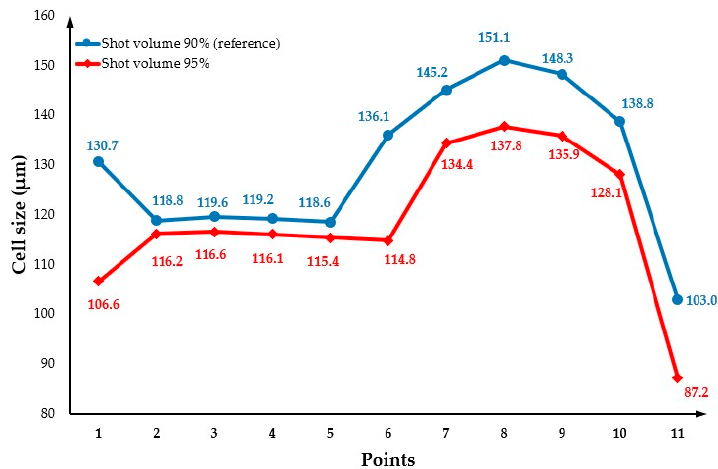
Figure 24. Cross-section variation in cell size as a function of shot volume.